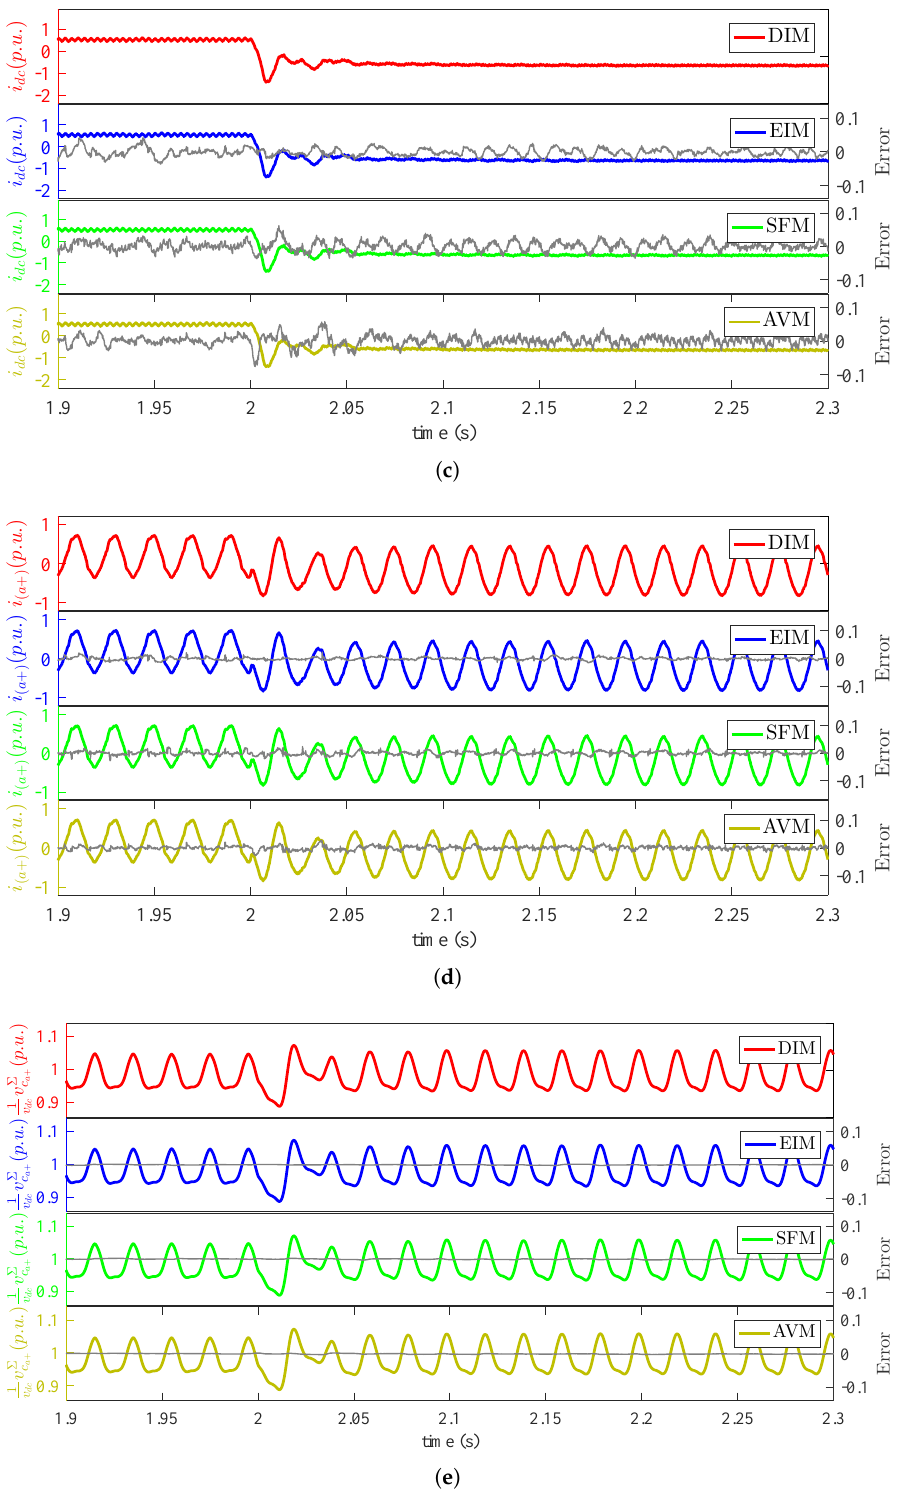
Figure 8. Real power reversal. ( a ) Real powerinjectedin theAC-grid P andthemodelerror; ( b ) reactive powerinjectedin theAC-grid Q andthemodelerror; ( c ) DC current i dc andthemodelerror; ( d ) positive arm current i ( a +) andthemodelerror; ( e ) cumulativecapacitorvoltage v DIM, detailed ideal model; EIM, equivalent model; AVM, average arm